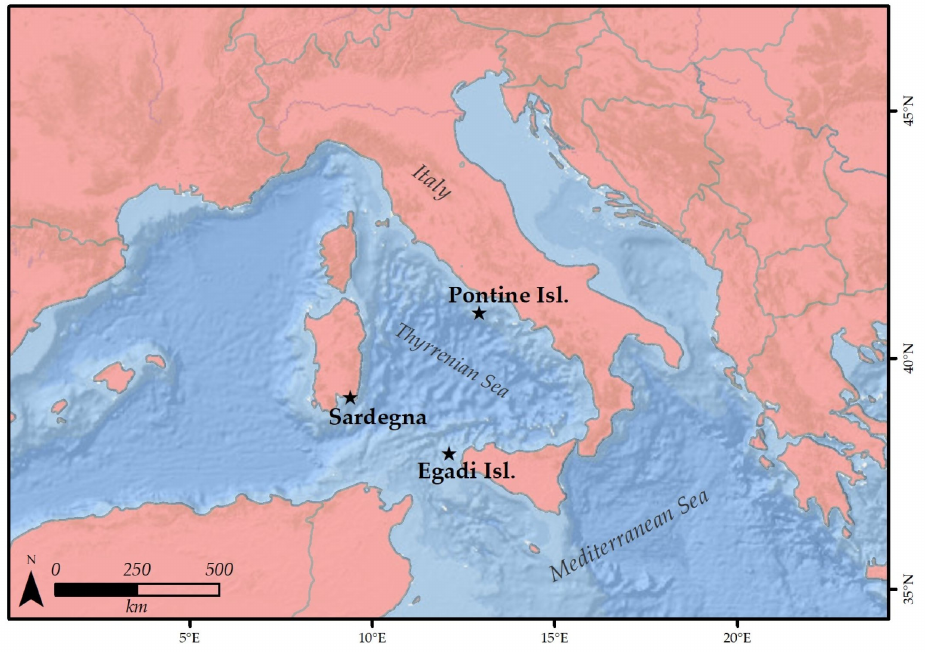
Figure 1. Map with the stations where samples have been collected. Service Layer Credits: Esri, Garmin, GEBCO, NOAA NGDC, and other